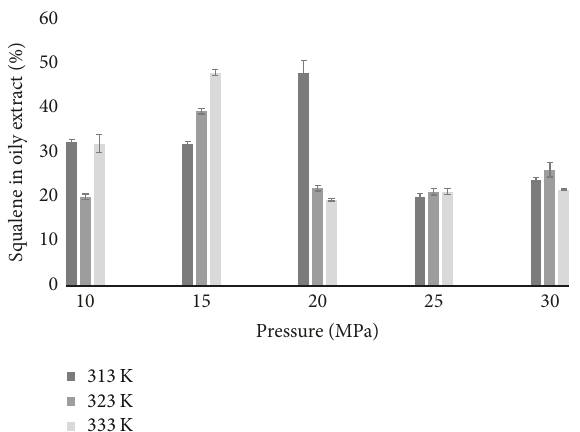
Figure 3: Squalene content in amaranth oily extracts (%) obtained at different operating conditions by SCFE from puffed seeds.